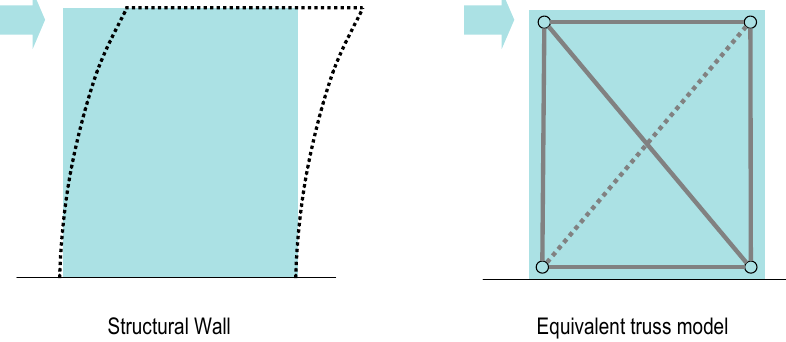
Figure 11. Modeling of an individual structural wall for the time history analysis.